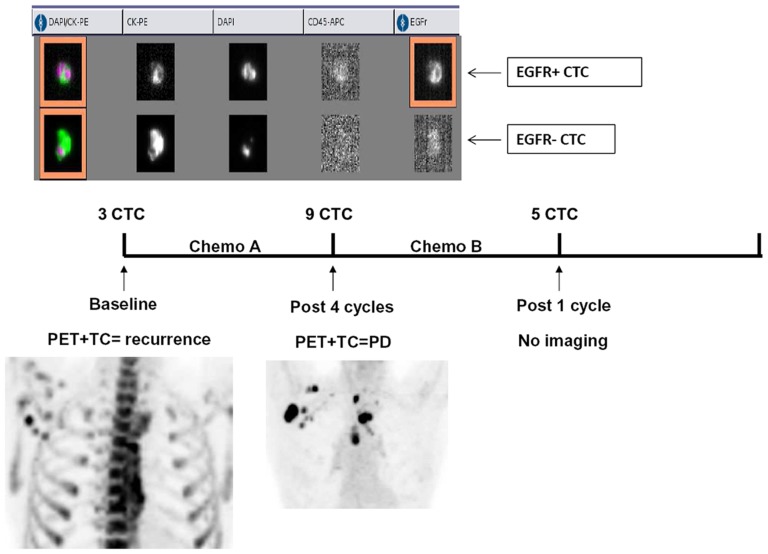
Example of CTCs analysis in a patient with mediastinal and axillary nodal metastases from an oropharyngeal squamous cell carcinoma.(A) the CellSearch output of baseline CTC analysis showing two CTCs with heterogeneous EGFR expression. (B) Timeline of CTC analysis and treatments. (C) Correlative imaging analysis by CT/PET at baseline and after chemotherapy. In this patient 3 CTCs were detected at baseline. After 4 cycles of a chemotherapy, CTC number rised to 9 suggesting progressive disease then confirmed by CT/PET imaging.